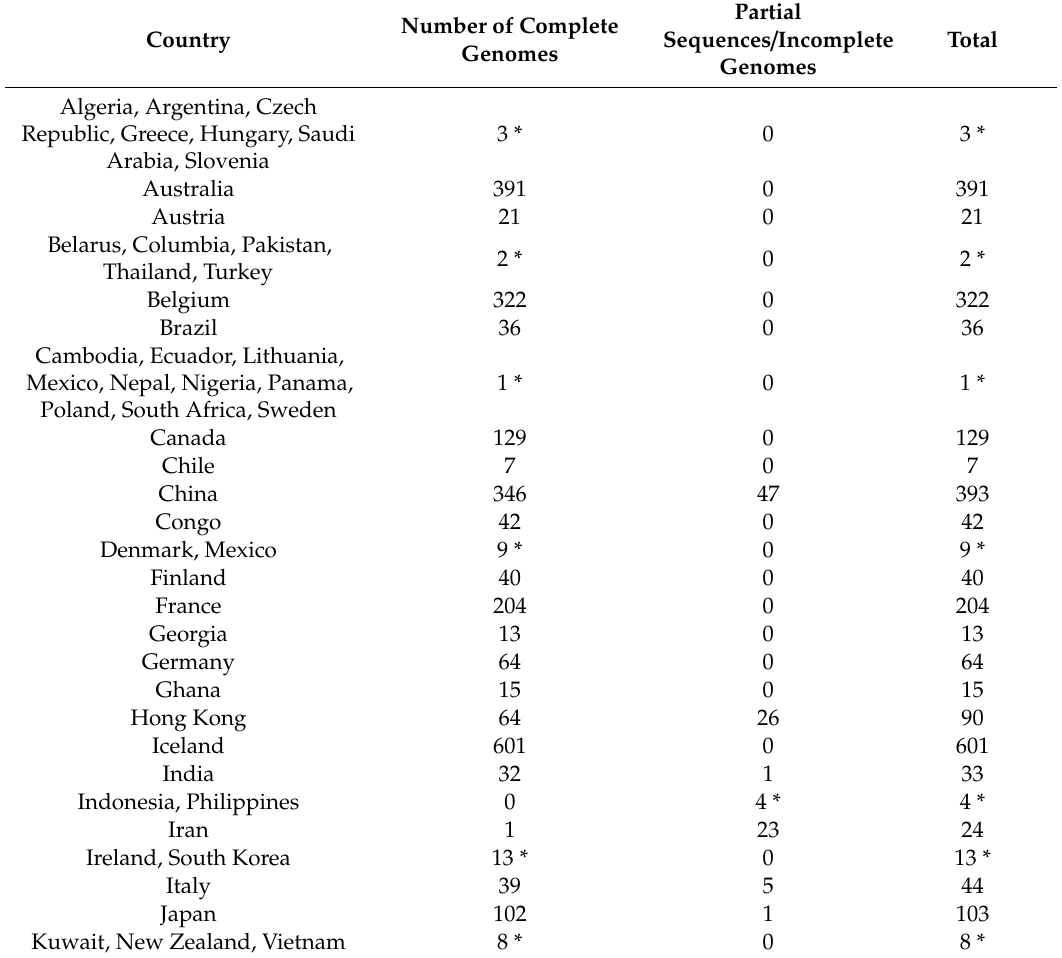
Table 2. Number of completed genomes, partial sequences, or incomplete genomes of severe acute respiratory syndrome coronavirus-2 (SARS-CoV-2) from di ff erent countries submitted to the Global Initiative on Sharing All Influenza Data (GISAID) as of 14 April 2020. Partial Number of Complete Country Sequences / Incomplete Genomes Genomes